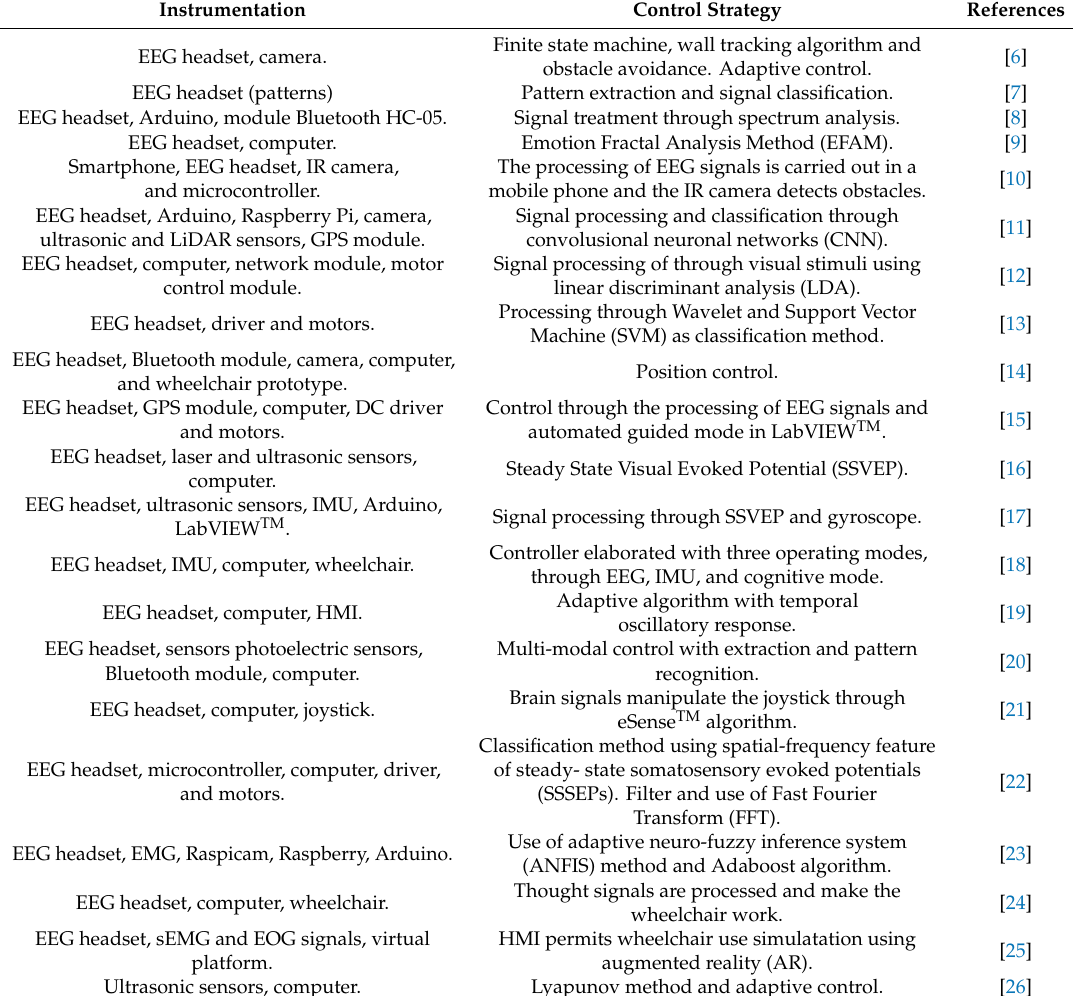
Table 4. Instrumentation and control strategies for BCI